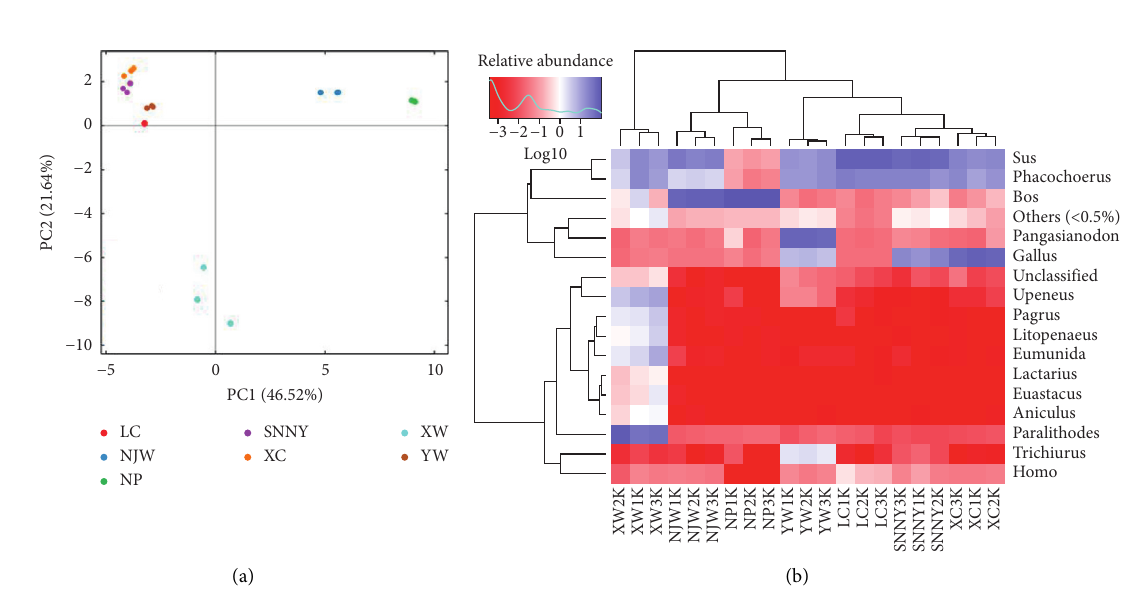
Figure 2: Organism components and abundance differentiated the seven commercial